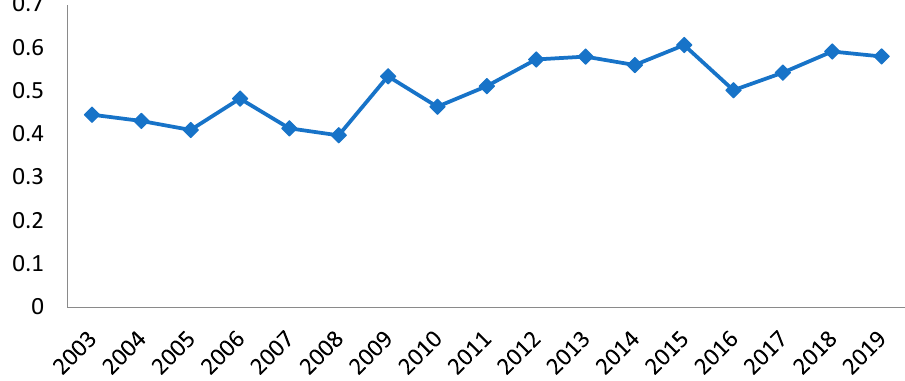
Figure 2. The Trend of urban land green use efficiency in Chinese cities.